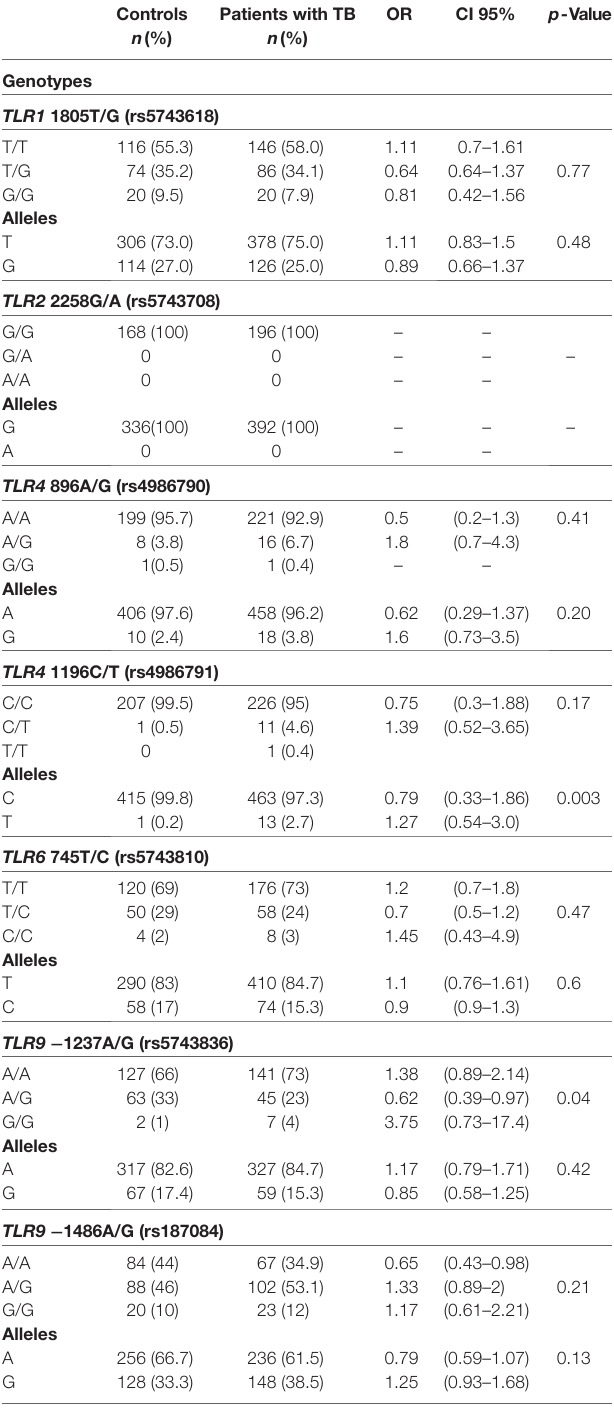
TaBle 3 | Genotypes and allele frequencies of the TLRs polymorphisms in healthy controls and patients with